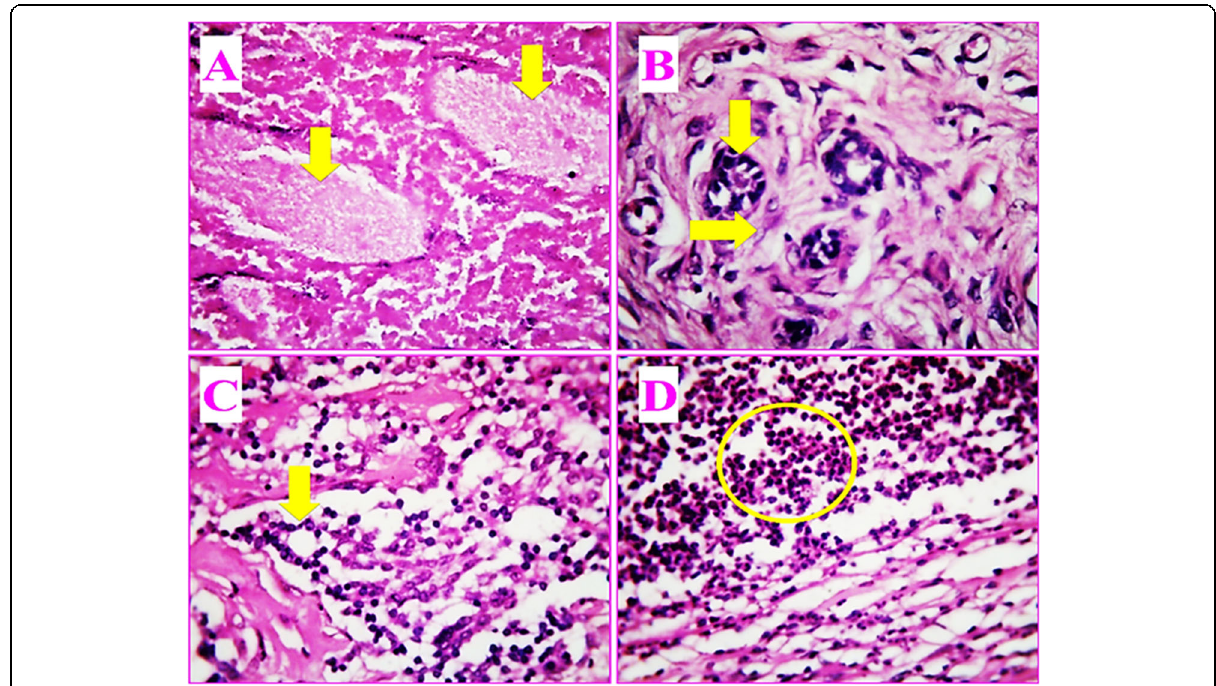
Fig. 3 Histopathology of breast tissues after T. chebula treatment. a A section from breast shows infiltrating ductal carcinoma (down arrows) (group II). b A section from breast shows areas of adenosis (down arrow) and fibrosis (straight arrow) (group III). c A section from the breast shows micro glandular adenosis (down arrow) (group IV). d A section from the breast shows infiltration of neutrophils (group